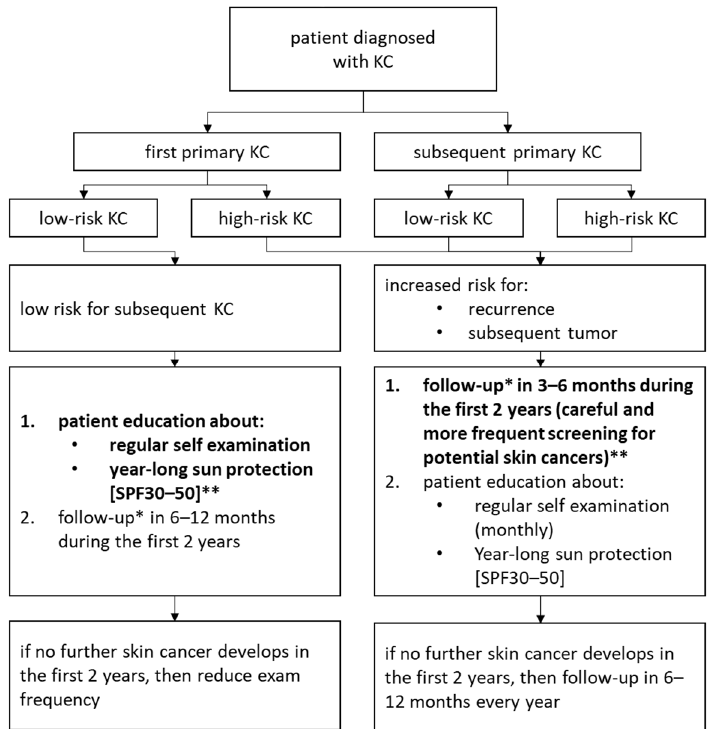
Figure 3. Recommendation for follow up depending on skin cancer. * follow up: full body dermatology exam and dermatoscopy. ** the crucial prevention marked in bold.